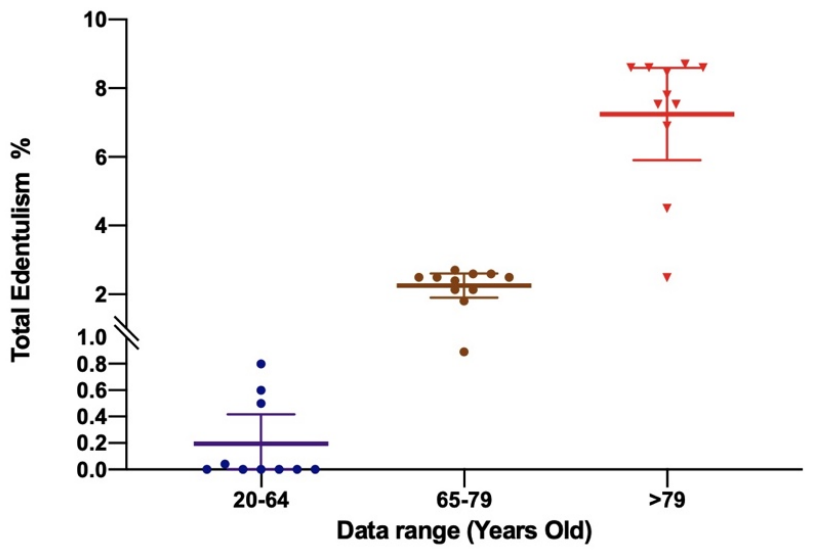
Figure 1. Total edentulism (%) among age groups 20–64, 65–79, and over 79 years old. (Mean ± 95% CI). In the country, edentulous people between 65 and 79 years old was 2.52%, with the year 2018 being the lowest reported rate (0.8%); Regarding the population over 79 years old, the average edentulism was 7.25%, the highest data reported for this surveillance system. In 2018, the lowest rate was 2.48%, while the highest was the year 2019 with the year 8.6% (Table